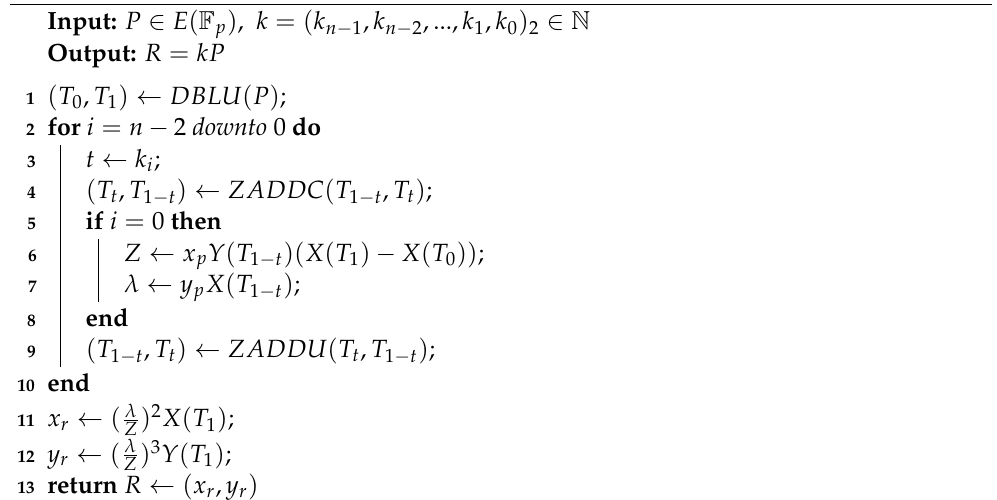
Algorithm 2: Montgomery ladder with co-Z